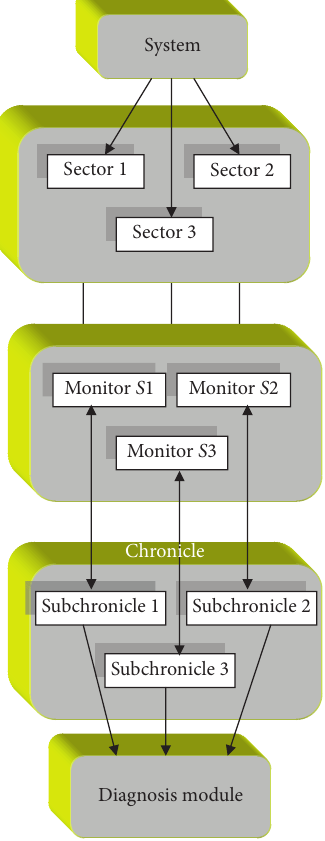
Figure 8: Distributed monitoring architecture based on chronicles.